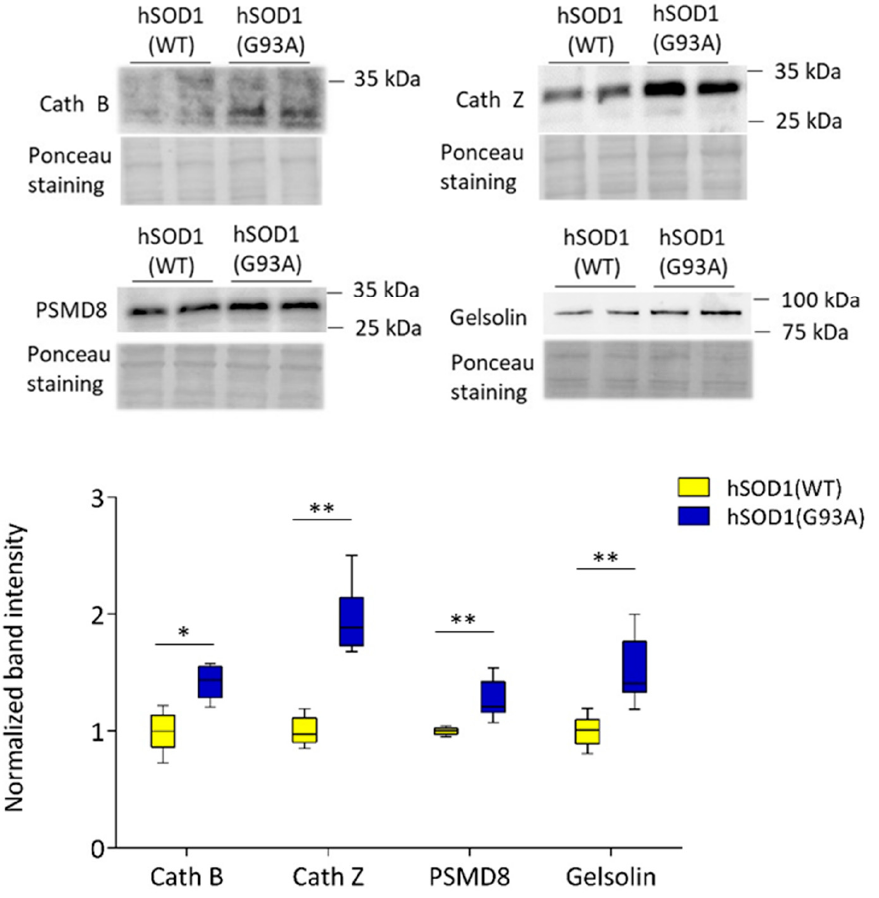
Figure 4. WB validates the hSOD1(G93A)-dependent overexpression of proteins involved in proteolysis. WB validation of Cath B, Cath Z, PSMD8, and Gelsolin abundance in hSOD1(G93A) and hSOD1(WT) primary cultures of spinal cord astrocytes. In the left panel, representative WBs and the corresponding Ponceau stained membranes are reported. In the right panel, the densitometric analysis of CathB, CathZ, PSMD8, and Gelsolin immunoreactive bands in the different astrocyte samples normalized to the optical density of the corresponding Ponceau-stained lanes are reported. n = 5, * p < 0.05, ** p < 0.01 (Mann–Whitney U test). Other details are as in the legend of Figure 3.